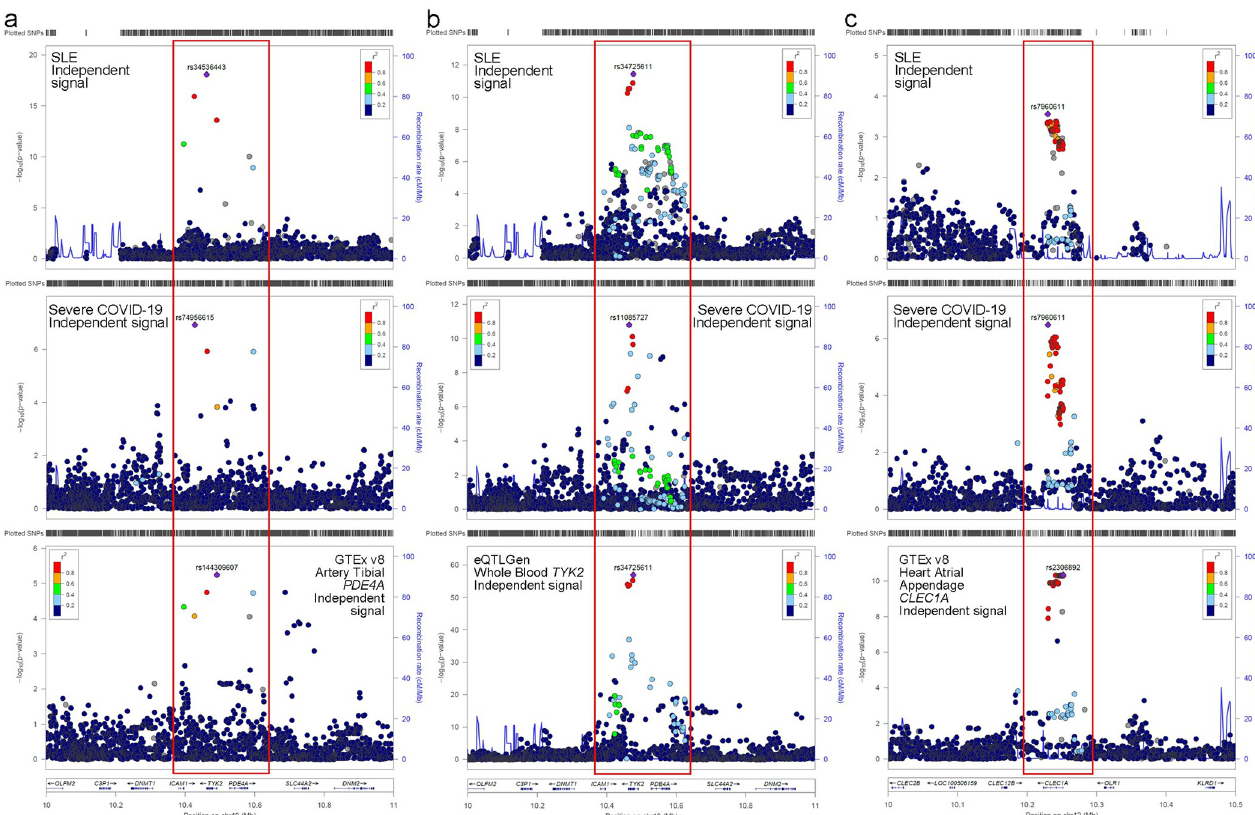
Fig 4. Locus zoom plots across loci for marginal associations with SLE, severe COVID-19 and eQTL. a) PDE4A locus, both diseases’ signal-B colocalized with eQTL for PDE4A . b) TYK2 locus, both diseases’ signal-A colocalized with eQTL for TYK2 . c) CLEC1A locus, both diseases colocalized with eQTL for CLEC1A . The LD (r 2 in 1000 Genome project Phase 3 EUR) is identified by color.